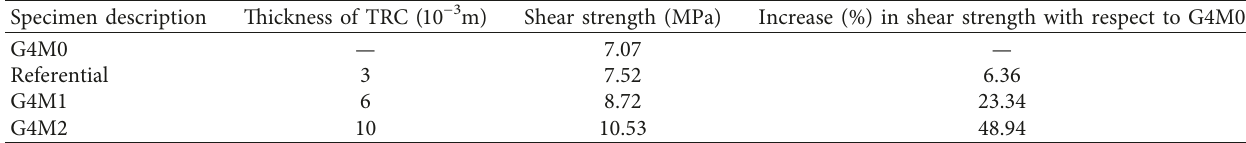
Table 15: Shear strength response of specimens with different thicknesses of TRC.